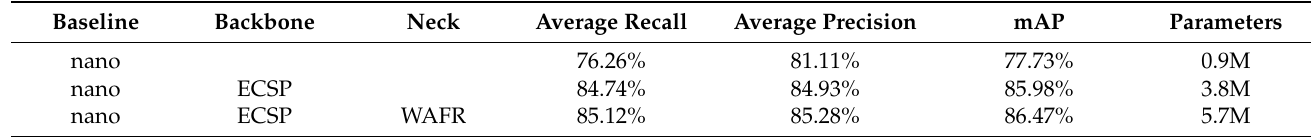
Table 5. Ablation experiments for the proposed method.